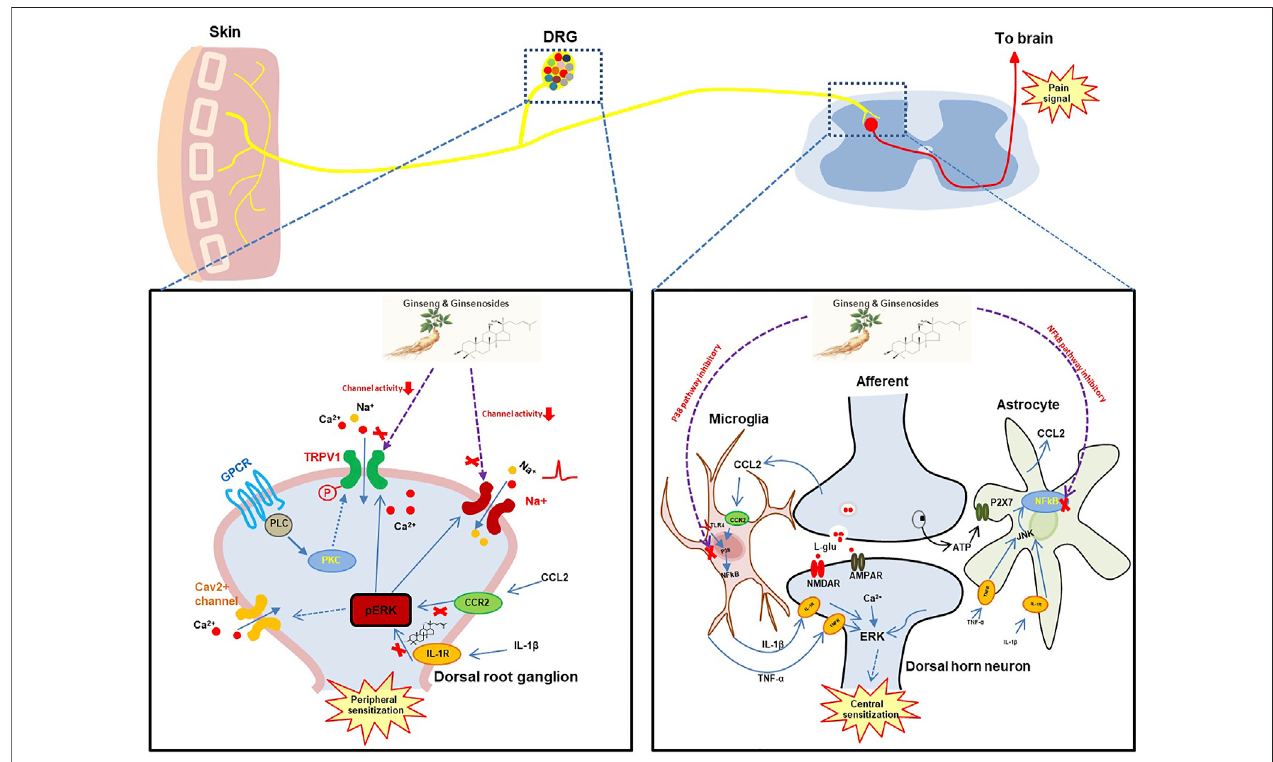
FIGURE 1 | The hypothetical analgesic action mechanisms of ginseng and ginsenosides. DRG, dorsal root ganglion; TRPV1, transient receptor potential cation channelsubfamilyVmember1;GPCR,Gprotein-coupledreceptor;PLC,phospholipaseC;PKC,proteinkinaseC;CCR2,C-Cmotifchemokinereceptor2;CCL2,C-C motif chemokine ligand 2; TLR4, Toll-like receptor 4; JUK, Janus kinase; NMDAR, N-methyl-D-aspartate receptor;AMPAR, α -amino-3-hydroxy-5-methyl-4- isoxazolepropionic acid